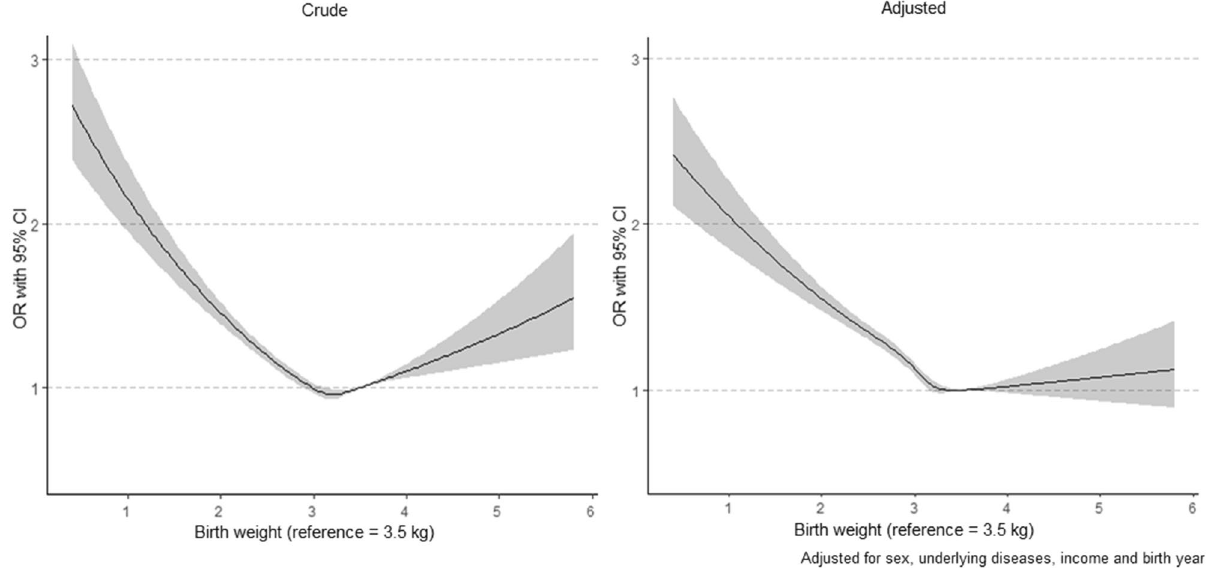
Figure 2. Crude and adjusted association between birth weight as a continuous variable expressed as cubic spline and ADHD.